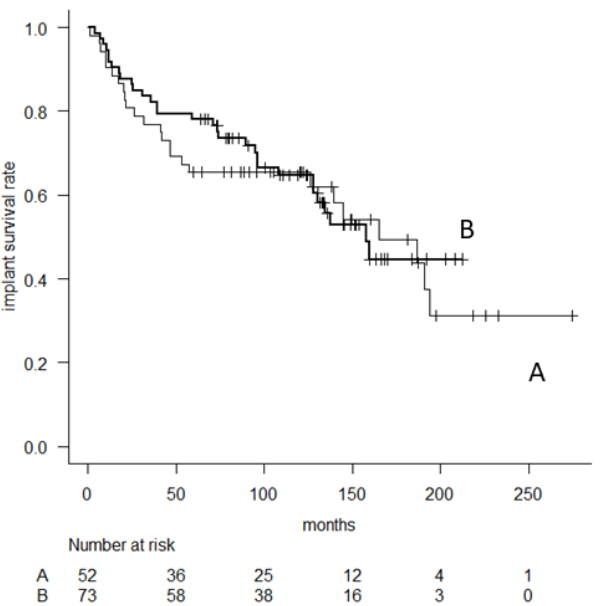
Figure 4. Kaplan–Meier curve comparing patients with cement ( A ) and cementless ( B ) femoral stem fixation.